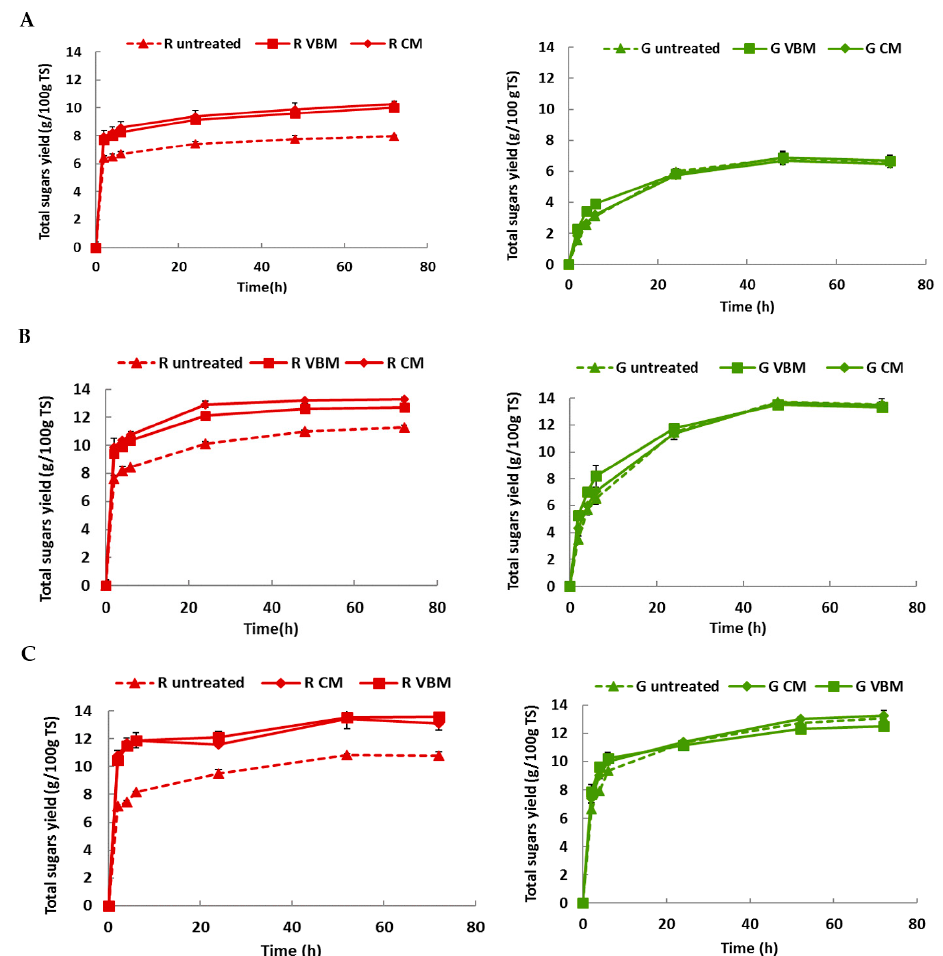
Figure 4. Total sugars released after 72 h of enzymatic hydrolysis for untreated and milled (G: Green, R: Red) macroalgae with an enzyme dosage of ( A ) 3.4; ( B ) 10 and ( C ) 30 g/L. Values correspond to mean ± SD of measurement performed in duplicate.